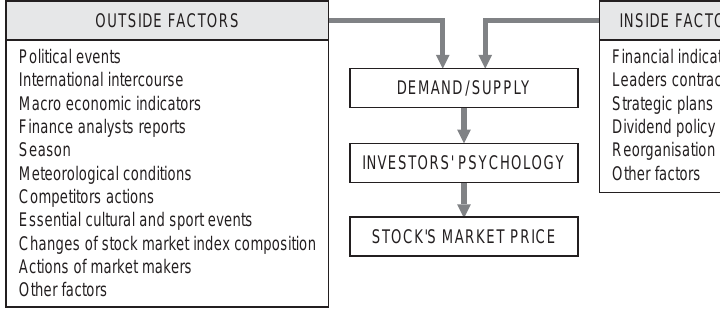
Fig. 1. Three-stage system of stock price volatility